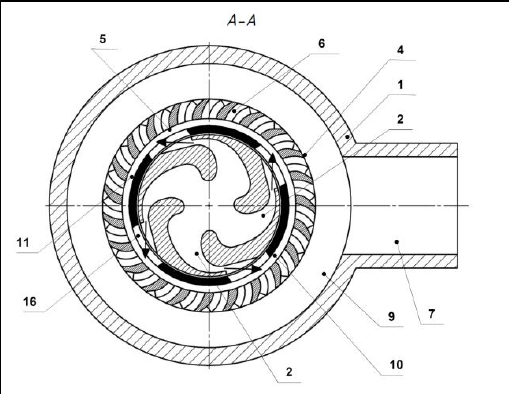
Figure 3. Schematic of the mesh turbine, A−A cross-section with the open nozzle: 1- stator; 2- inlet nozzles; 4- outer protrusions; 5- inner protrusions; 6- flow channels; 7- outlet channel; 9- vortex chamber; 10- circulating annular channel; 11- movable control sleeve; 16-